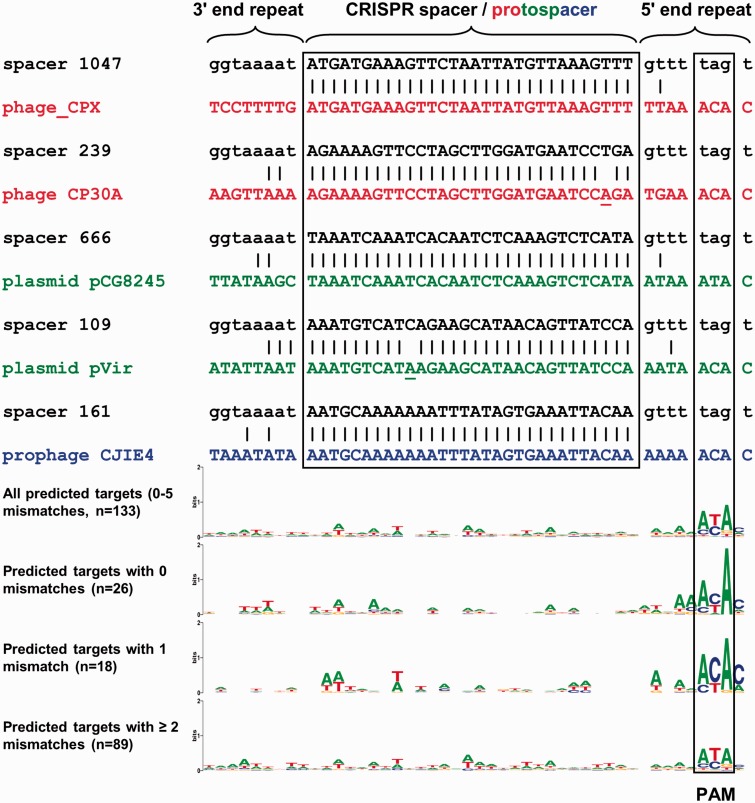
Identification of putative targets for C. jejuni and C. coli crRNA sequences and identification of a PAM motif (Deveau et al. 2008; Horvath et al. 2008; Mojica et al. 2009). The figure shows examples of protospacers in Campylobacter phages (2), plasmids (2), and a prophages/insertion element (1). Sequences in black represent spacer sequences with the allele number from supplementary table S5, Supplementary Material online, red represents phages, green represents plasmids, blue represents chromosomally integrated prophages/insertion elements of C. jejuni strain RM1221 (Fouts et al. 2005). The 3′-end of the upstream repeat and the 5′-end of the downstream repeat are shown for each spaces (black), as well as the upstream and downstream sequences of the protospacers. A full list of protospacers is given in supplementary table S5, Supplementary Material online. Weblogo analyses are shown below the alignment, to show a lack of sequence conservation in 133 protospacers and 5′ upstream sequence, but conservation of a 3′ downstream PAM motif (Deveau et al. 2008; Horvath et al. 2008; Mojica et al. 2009). The PAM motif is shown for protospacers with 0, 1, and ≥2 mismatches with the CRISPR spacer (n = 26, n = 18, and n = 89, respectively), and highlights the relative lack of conservation of the 5′-a(c/t)A-3′ PAM motif in protospacers with ≥2 mismatches.